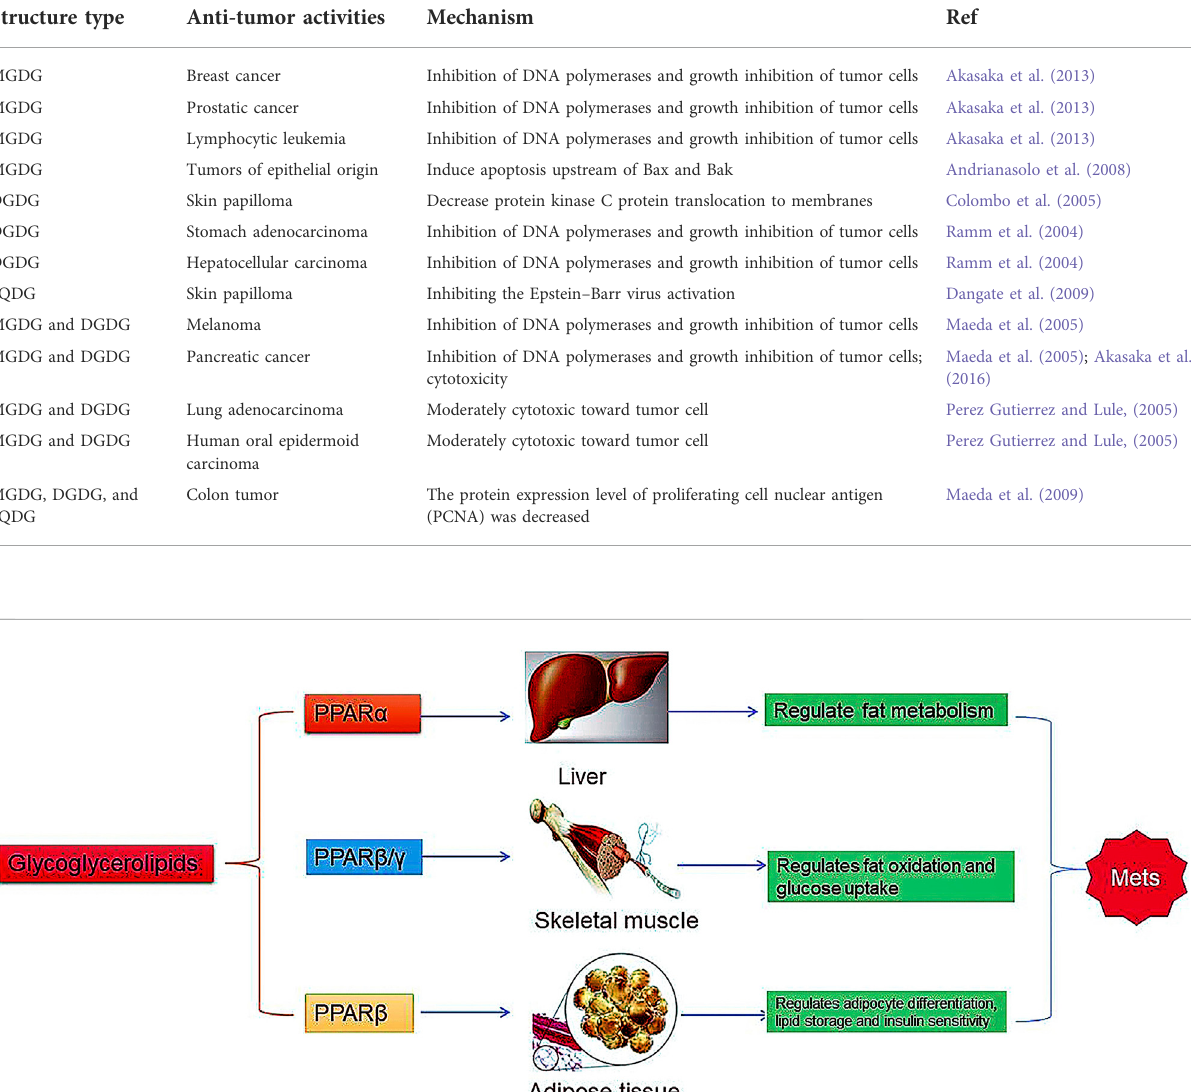
TABLE 2 Anti-tumor activities and mechanism of glyceroglycolipids.